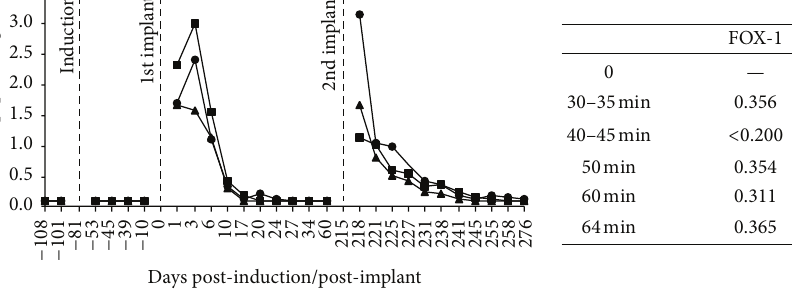
Figure 2: Serum porcine C-peptide levels of macrobead implanted dogs following 1st and 2nd implant [(a): FOX-1 (triangle); HSX-1 (square); KOX-1 (circle)]. Porcine C-peptide was also detected in the peritoneal fluid of implanted study animals following glucose/arginine challenge. (b) Porcine-C-peptide was not determined (n.d.) at all timepoints for HSX-1 because fluid was not collected beyond 30–35 minutes.